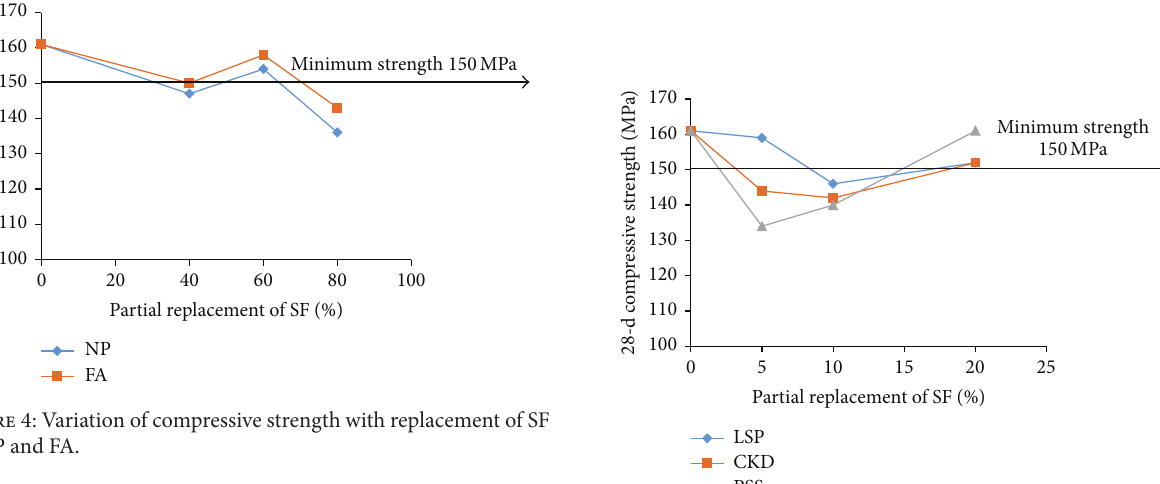
Figure 5: Variation of flow with replacement of SF by LSP, CKD, and PSS.